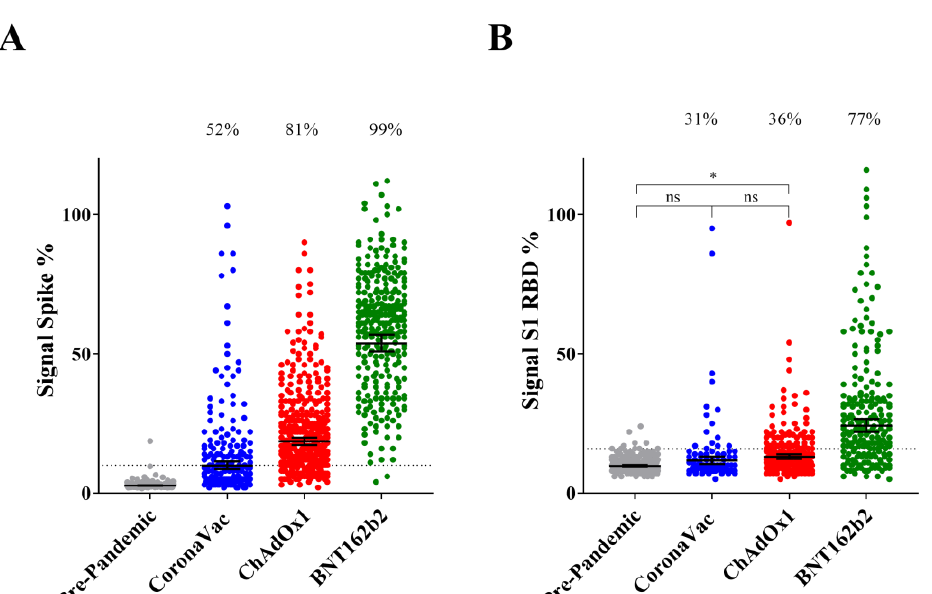
Figure 1. The IgG response to spike protein and S1 RBD accordingly to the vaccine type. IgG levels reactive to spike protein ( A ) and S1 RBD ( B ) in participants negative for COVID-19 who completed primary vaccination (2nd dose) between 10 and 240 days. Bars represent the geometric mean with 95% CI, the dashed line indicates the seropositive cutoff. Pre-pandemic samples were plotted as controls. One-way ANOVA analysis was performed, all comparisons were significant at p < 0.0001 except when indicated in the graph (* p < 0.05), (ns, not significant). Numbers above the graph indicate seroconversion rates. The dashed line indicates the seropositive assay cutoff.